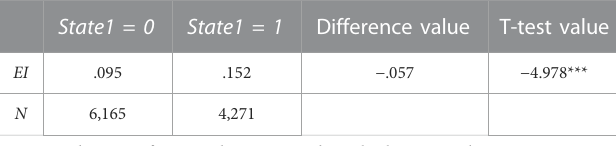
TABLE 3 T-test for the mean of the variables